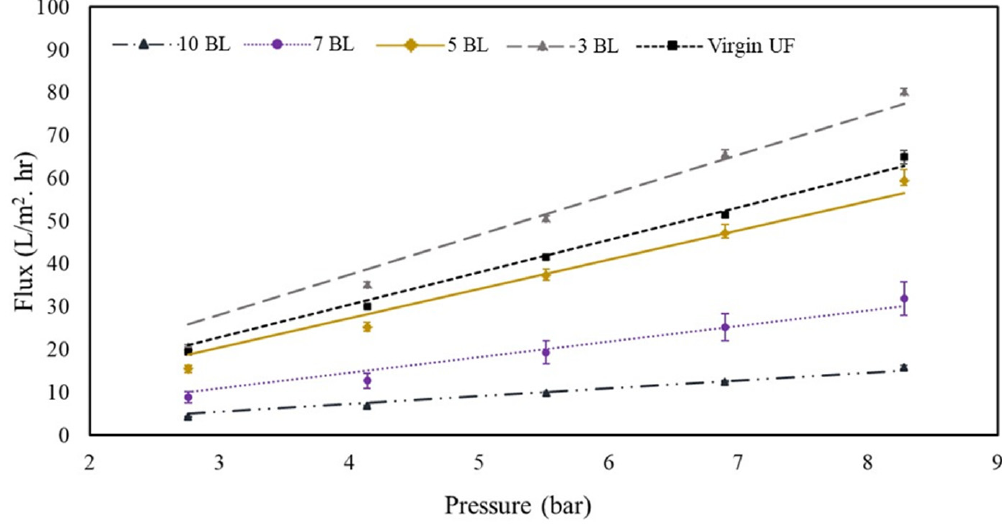
Figure 9. Effect of the number of PAH/PAA bilayers deposited on membrane permeate flux. Figure 9. E ff ect of the number of PAH / PAA bilayers deposited on membrane permeate